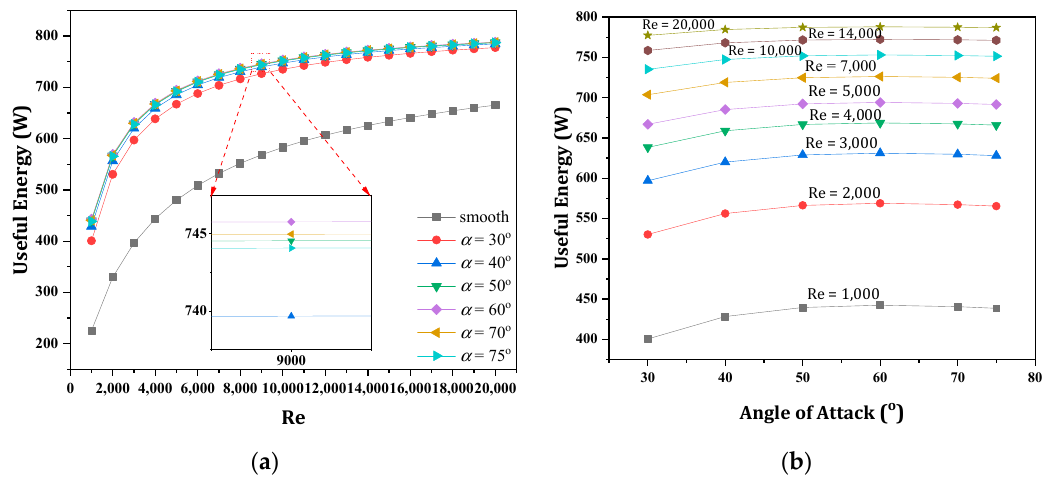
Figure 9. Useful energy versus ( a ) Re at various angles of attack (in the range of 30 – 75° ) and ( b ) angles of attack for various Re (in the range of 1000 – 14,000 ).